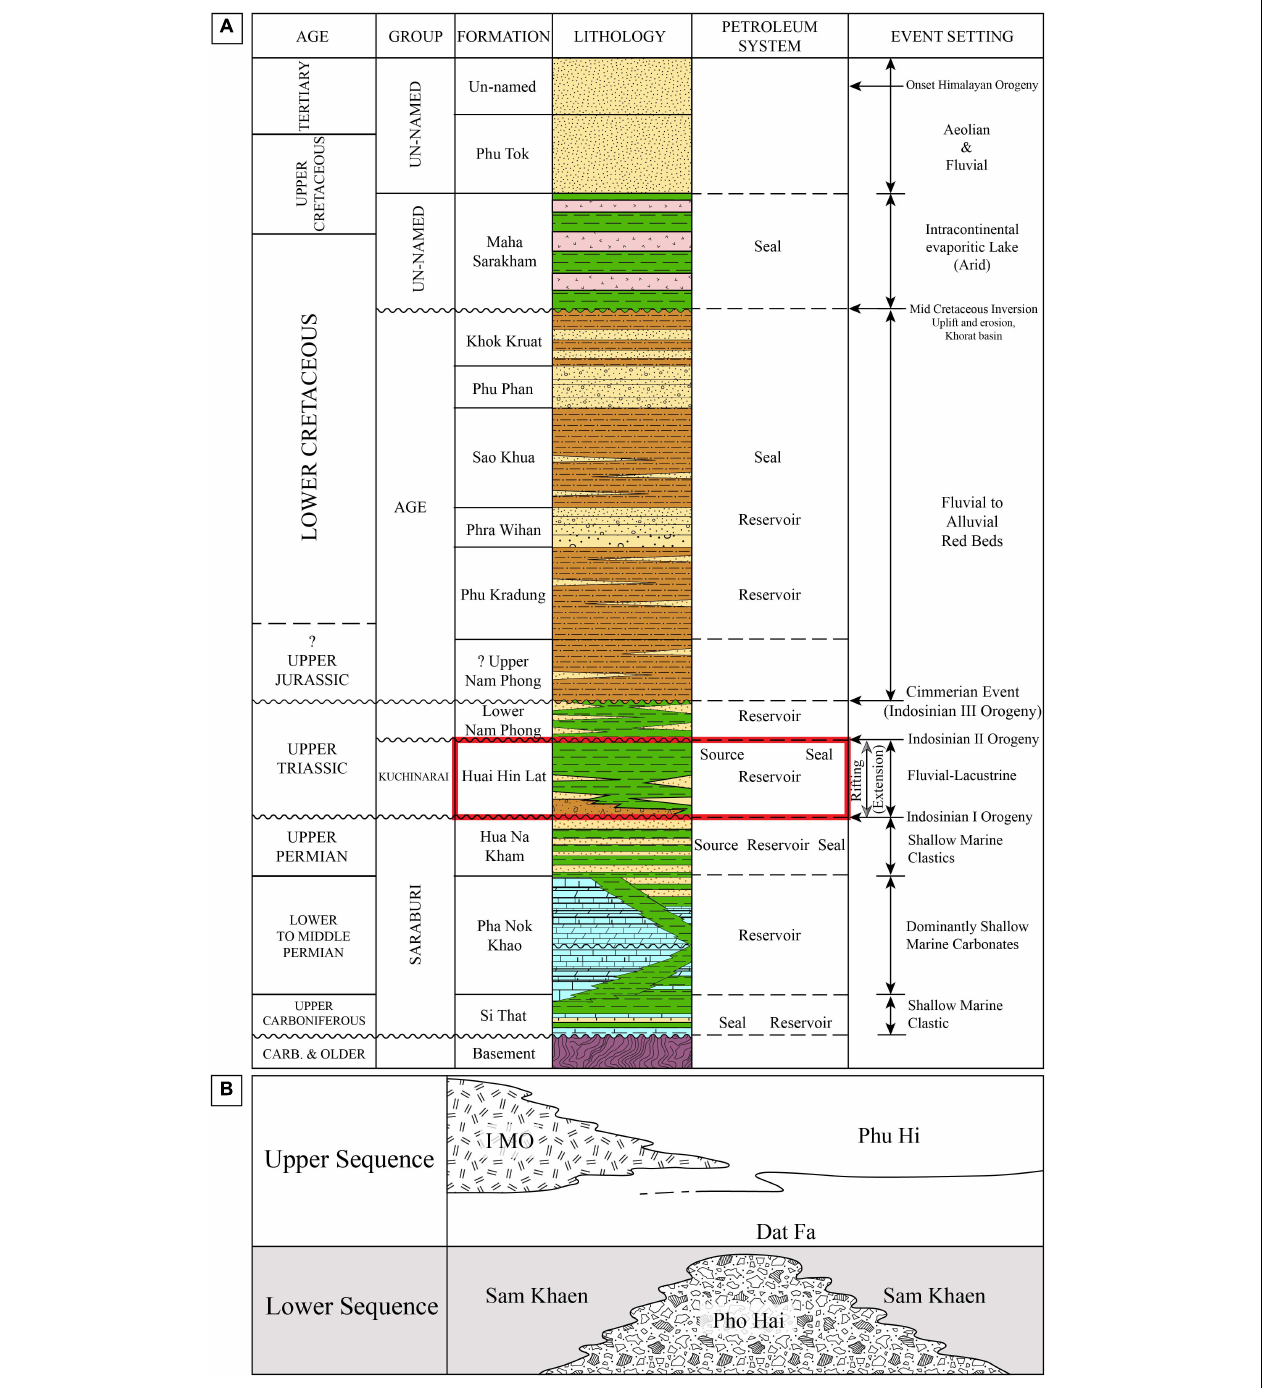
FIGURE 1 | (A) Stratigraphy of the Khorat plateau including petroleum system elements and key events (modified from Racey, 2011). The red box highlights the Huia Hin Lat interval which is the studied Formation. (B) The classified member of the Huai Hin Lat Formation (Chonglakmani and Sattayarak, 1978).